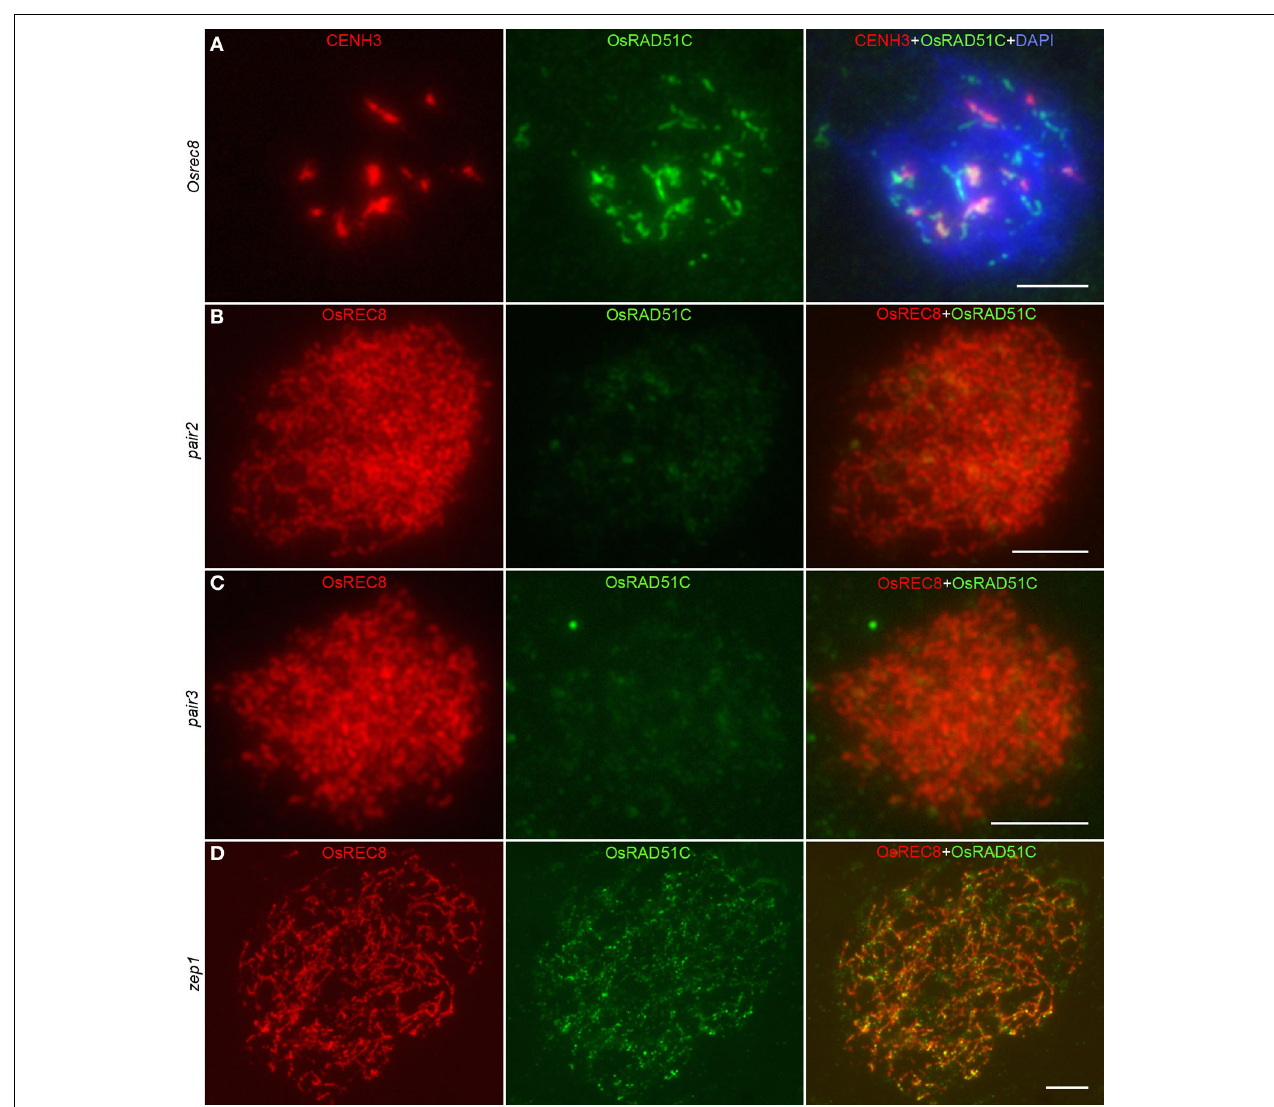
FIGURE 6 | The localization of OsRAD51C at leptotene in different meiotic mutants of rice. (A) Osrec8 ; (B) pair2 ; (C) pair3 ; (D) zep1 . The CENH3 signals (red) indicating the PMC in Osrec8 , and the